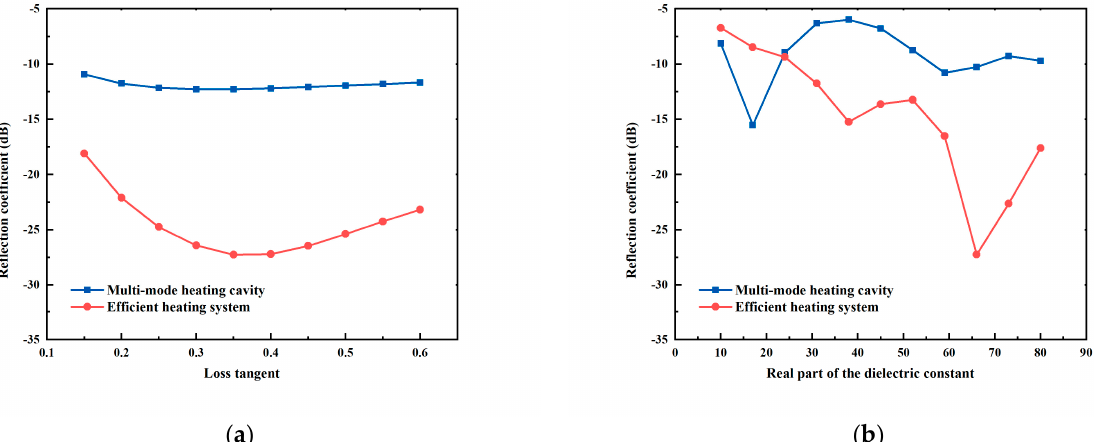
Figure 15. Comparison of the heating performance of multi-cavities and systems at different dielectric properties. ( a ) Variation of loss tangent, ( b ) variation of the real part of the dielectric constant.